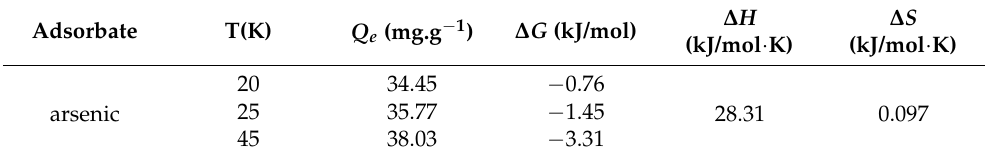
Table 4. Impact of temperature on sorption capacity and thermodynamic